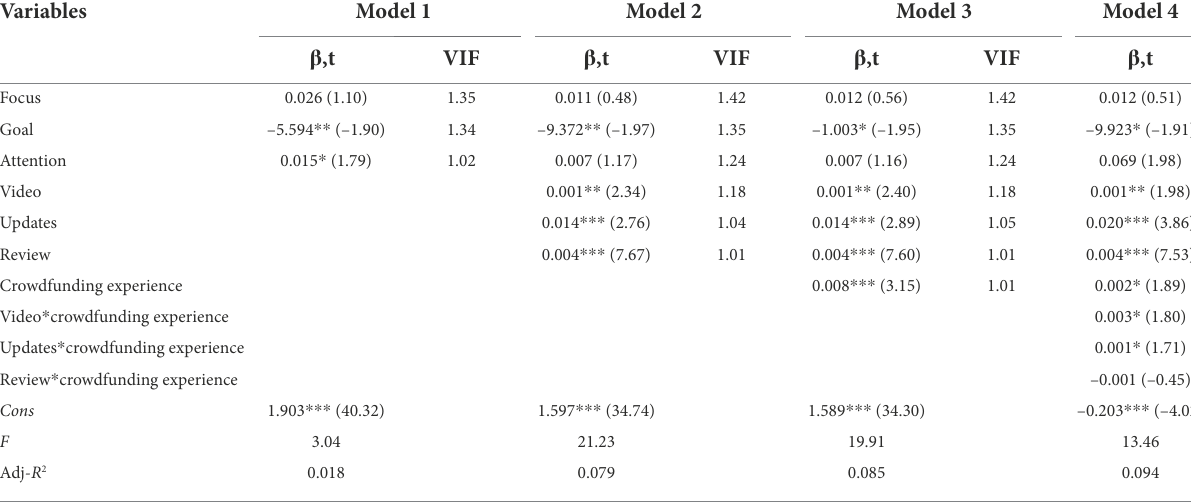
TABLE 3 Analysis of regression results for the effect of high and low signals on